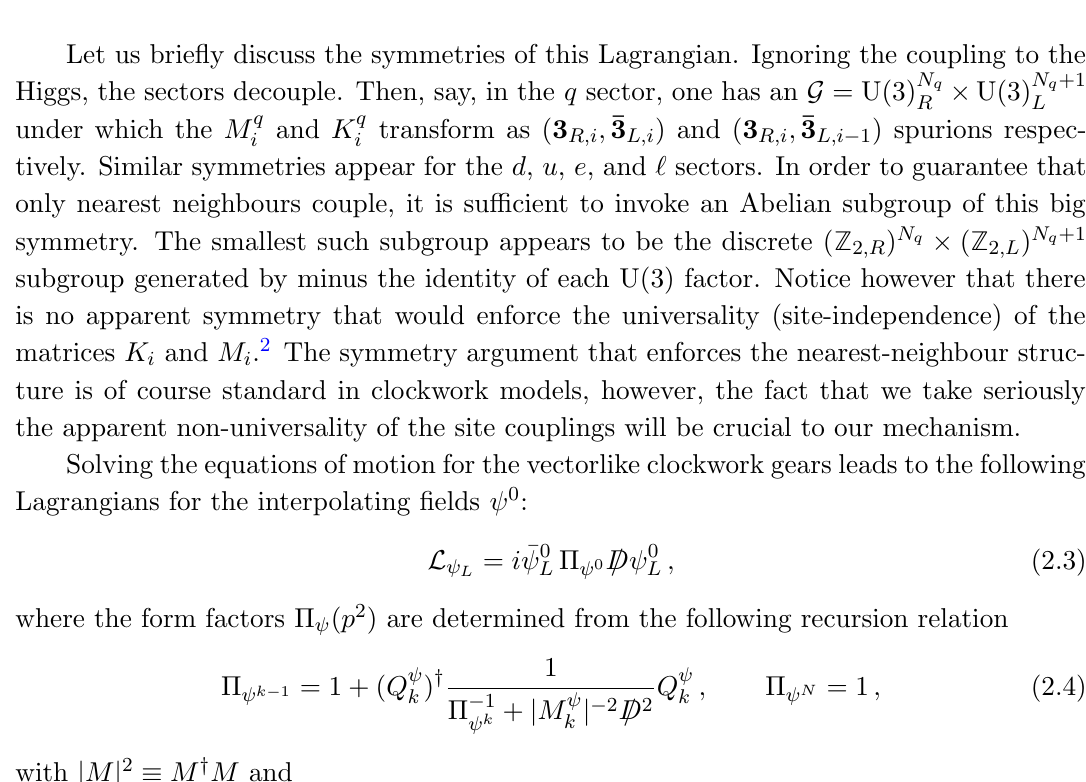
Figure 1. The generic clockwork chain. There are three left-handed zero